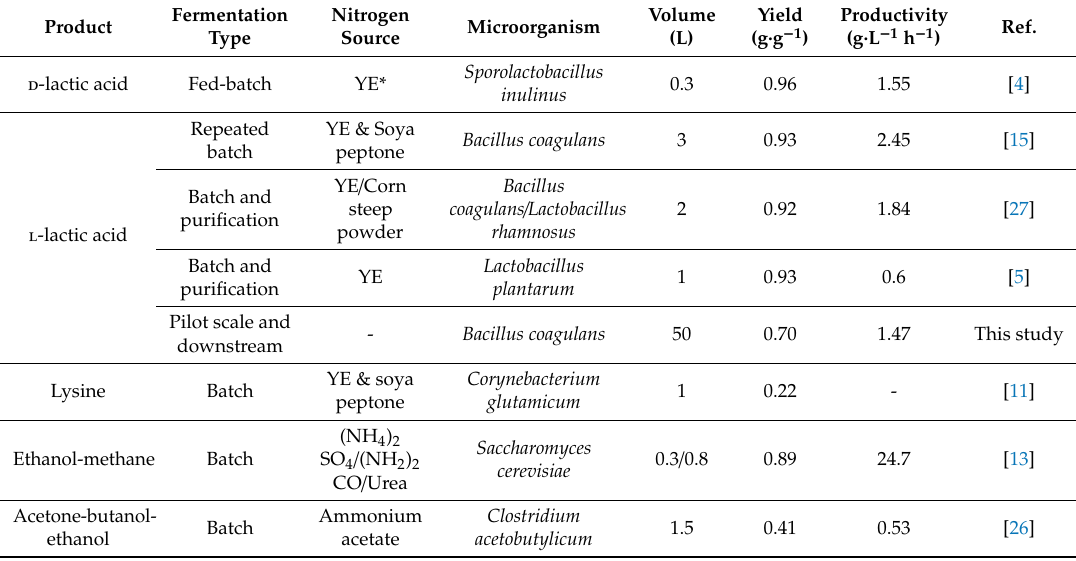
Table 2. Comparison between this work and previous studies on lactic acid and other fermentation products from